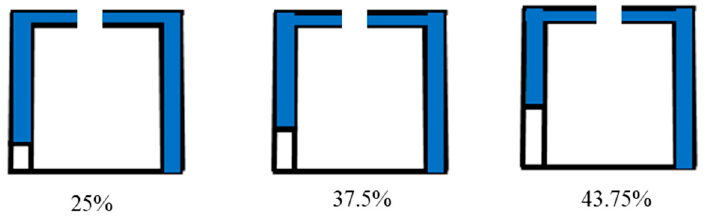
Figure 10. Average pneumatic power corresponding to the area ratio of orifice cross-section.